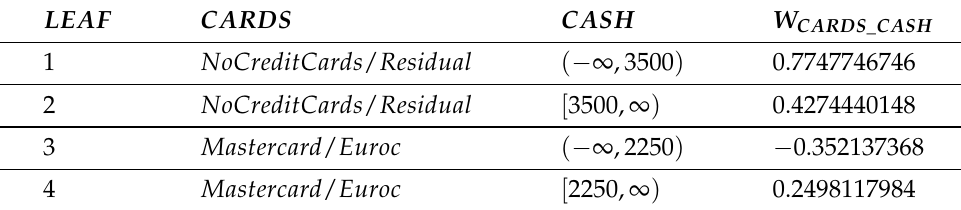
Figure 7. CART tree adjusted with variables CREDIT _ CARDS and CASH in CS _ ACCEPTS (depth = 2). Table 7. Values obtained for W CARDS _ CASH from the tree depicted in Figure